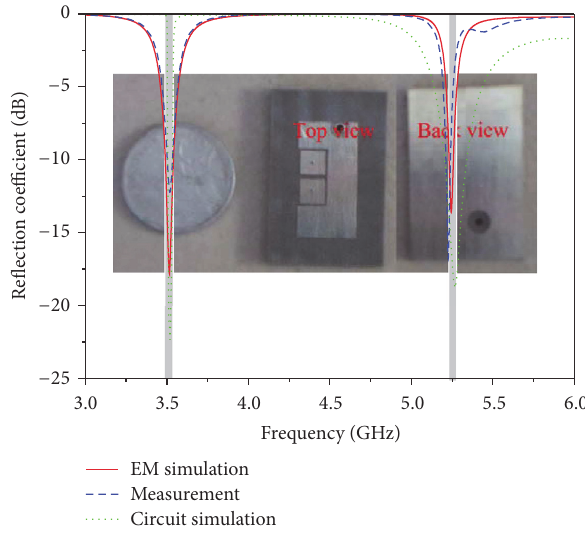
Figure 7: Simulated and measured return loss for the dual-band antenna with the photograph displayed in the inset. The shadow represents the − 10dB bandwidth of the proposed antenna.